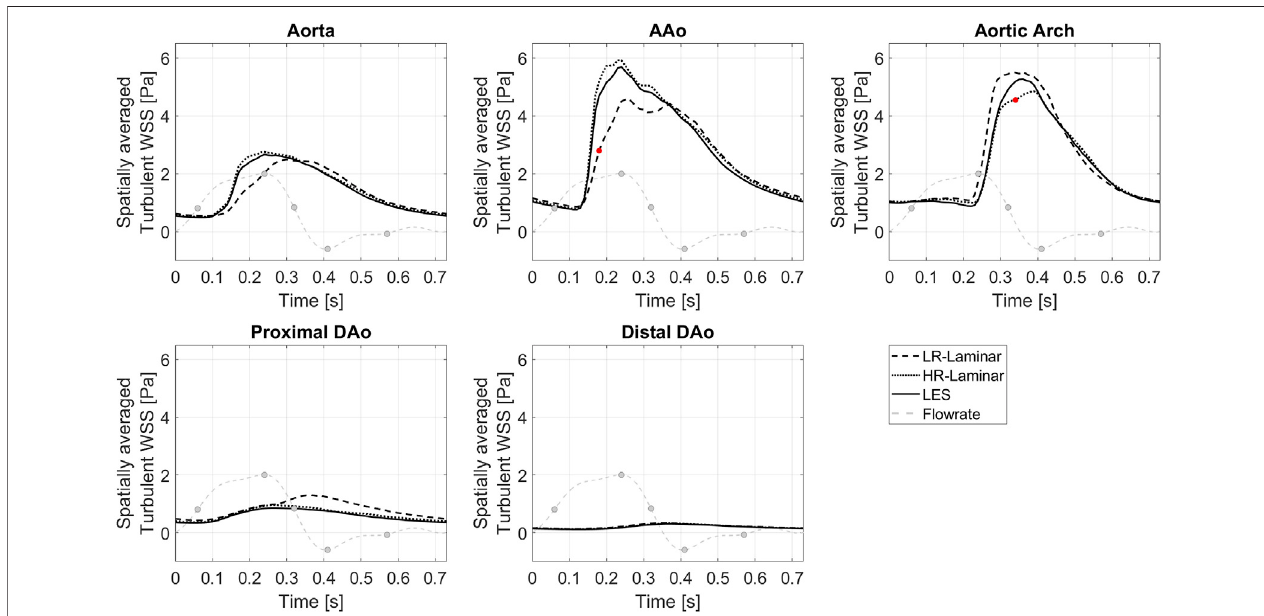
FIGURE10| TurbulentWSSspatiallyaveragedovertheentireaortaandeachROI,plottedoveracardiaccycle.LargestdifferencesrelativetoLESareindicatedby red markers. Key times throughout the cardiac cycle refer to maximum acceleration, peak systole, maximum deceleration, end systole and